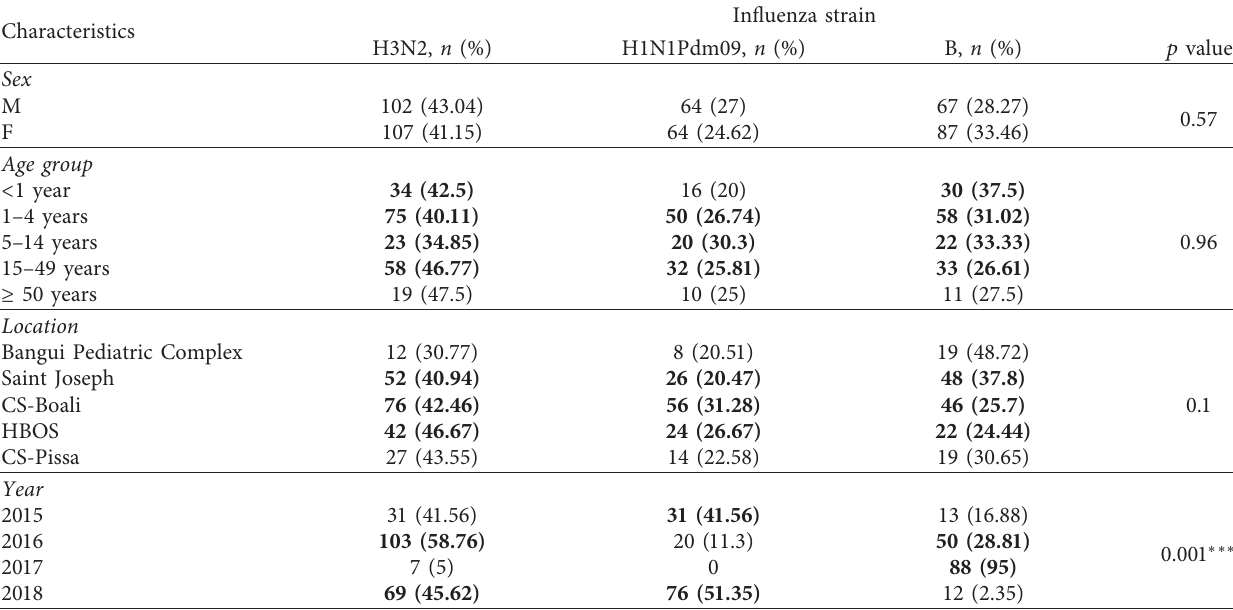
Table 2: Distribution of influenza virus infection according to demographic characteristics, Central African Republic, 2015–2018. Characteristics